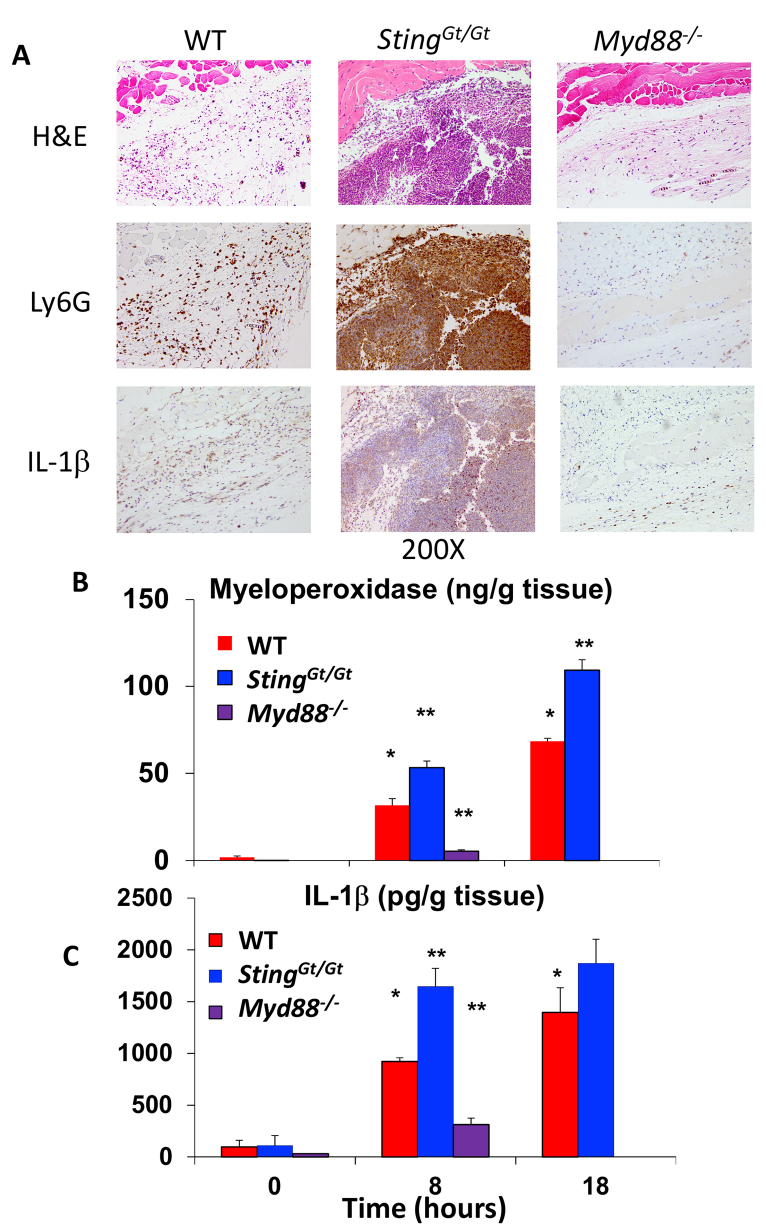
Fig 7. STING signaling suppresses neutrophil recruitment and IL-1 β production following cutaneous infection with S . aureus . (A) 18 hours after infection, skin was harvestedand histologyand immunohistochemistry was performed for Ly6G and IL-1 β . Representative exampleof high power (200X) images of skin from a WT, Sting Gt/Gt and Myd88 -/- mouse are shown. (B) Skin homogenates from WT and Sting Gt/Gt mice at 8 and 18 hours (n = 6 per group) and Myd88 -/- mice at 8 hours (n = 5) * p < 0.05vs baseline; ** p < 0.05vs WT stimulated at same time point sample by one way ANOVA with Tukey test. (C) IL-1 β expressionat 8 and 18 hours after S . aureus infectionin WT (n = 6 per time point), Sting Gt/Gt mice (n = 6 per time point), and Myd88 -/- mice (n = 5, 8 hour time point only). * p < 0.05vs baseline; ** p < 0.05vs WT stimulatedat same time point by one way ANOVA with Tukey test. All error bars denote standarderror of the mean.